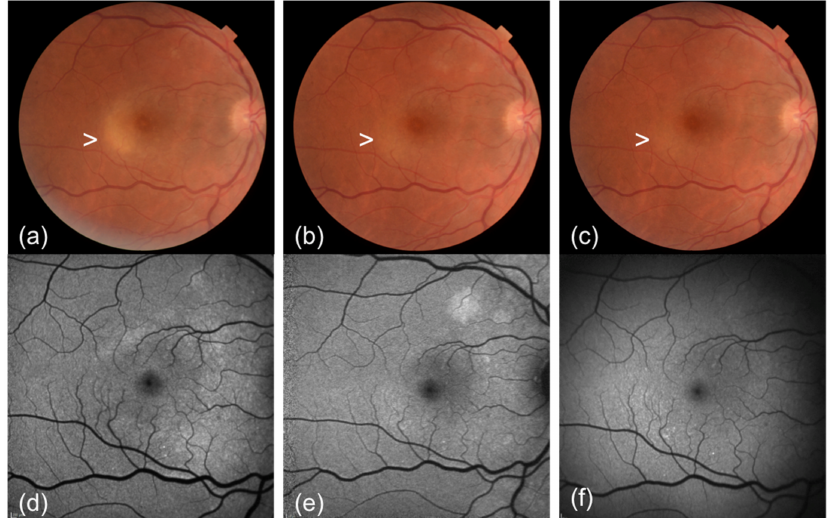
Figure 2: Colour fundus photograph (CFP) and fundus autofluorescence (FAF) changes of acute syphilitic posterior placoid chorioretinitis in the right eye over time. (a) CFP shows a yellow placoid lesion (white arrowhead) at the posterior pole which gradually fades 1 week after presentation (b) and 2 weeks after presentation (c). FAF shows increased AF in correspondence of the placoid lesion at presentation (d) with gradual normalisazion of the AF 1 week after presentation (e) and 2 weeks after presentation